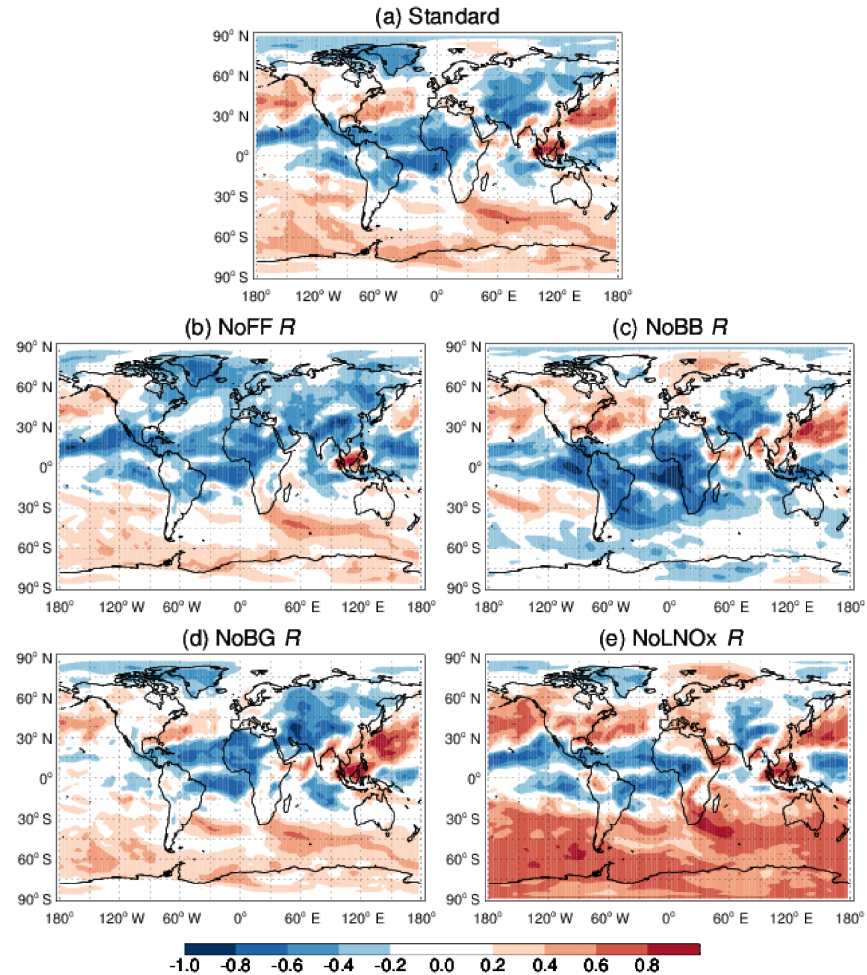
Figure 20. GMI/MERRA-simulated O 3 –CO correlations ( R ) at 618hPa (a) in the standard simulation and (b–e) when fossil fuel (FF), biomass burning (BB), biogenic (BG), and lightning NO x (LNO x ) emissions are individually suppressed (NoFF, NoBB, NoBG, and NoLNO x , respectively) in the model during July–August 2005. Results are calculated using 3-hourly model output. White areas denote absolute values of O 3 –CO correlation coefficients less than